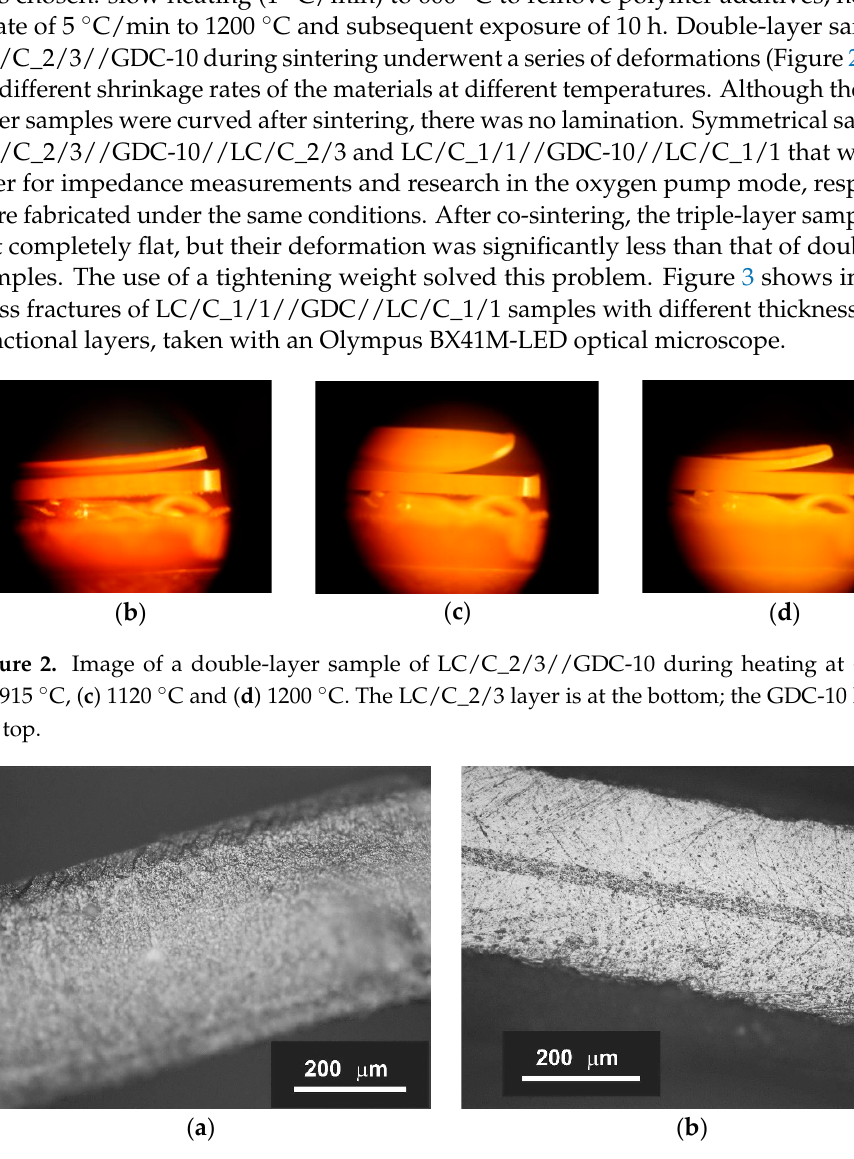
Figure 3. Microphotographs of cross fractures of symmetric LC/C_1/1//GDC//LC/C_1/1 samples with different thicknesses of the functional layers: ( a ) supporting electrolyte, ( b ) supporting dense electrode